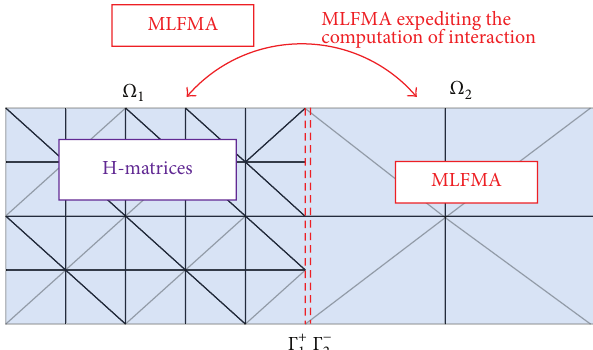
Figure 3: The systematic description of HS-DDM. In the first subdomain (left) with tiny meshes, hierarchical matrices method is used. In the second subdomain (right) with larger meshes, MLFMA is used.